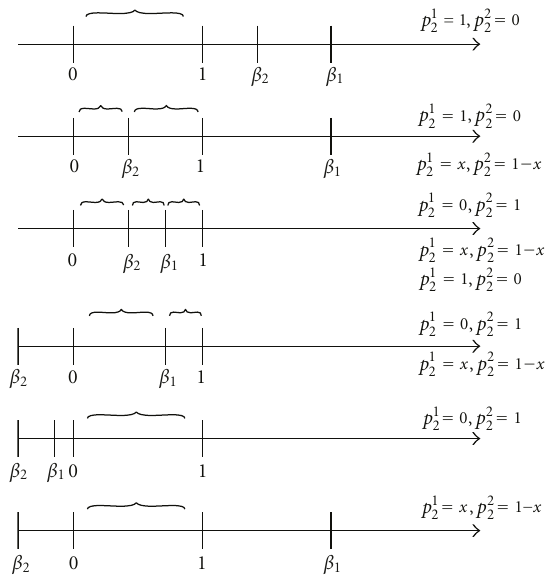
Figure 5: Power allocation strategies of the Stackelberg game in which 6 cases exist depending on the variables β 1 and β 2 . The X - axis depicts the strategy space for the leader ( p 1 1